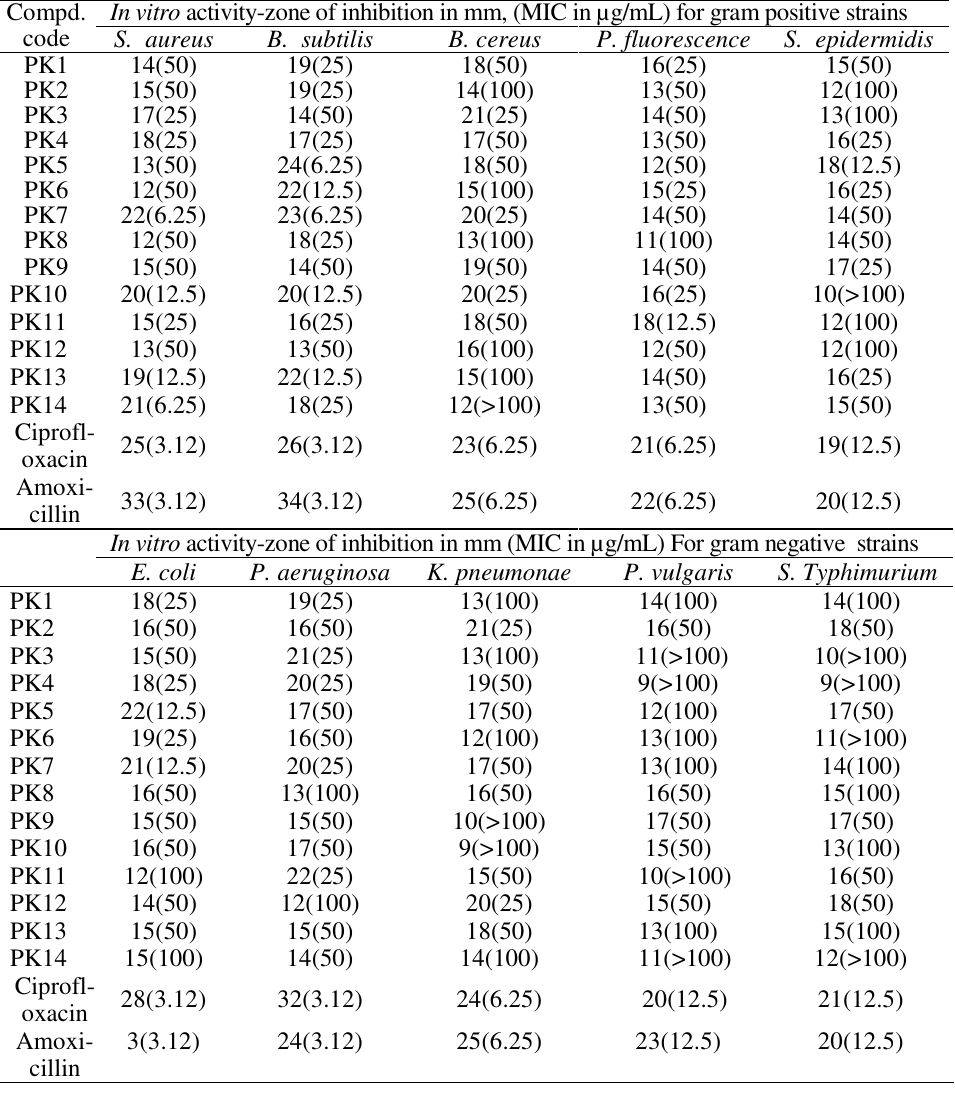
Table 3. Antibacterial activity of the synthesized